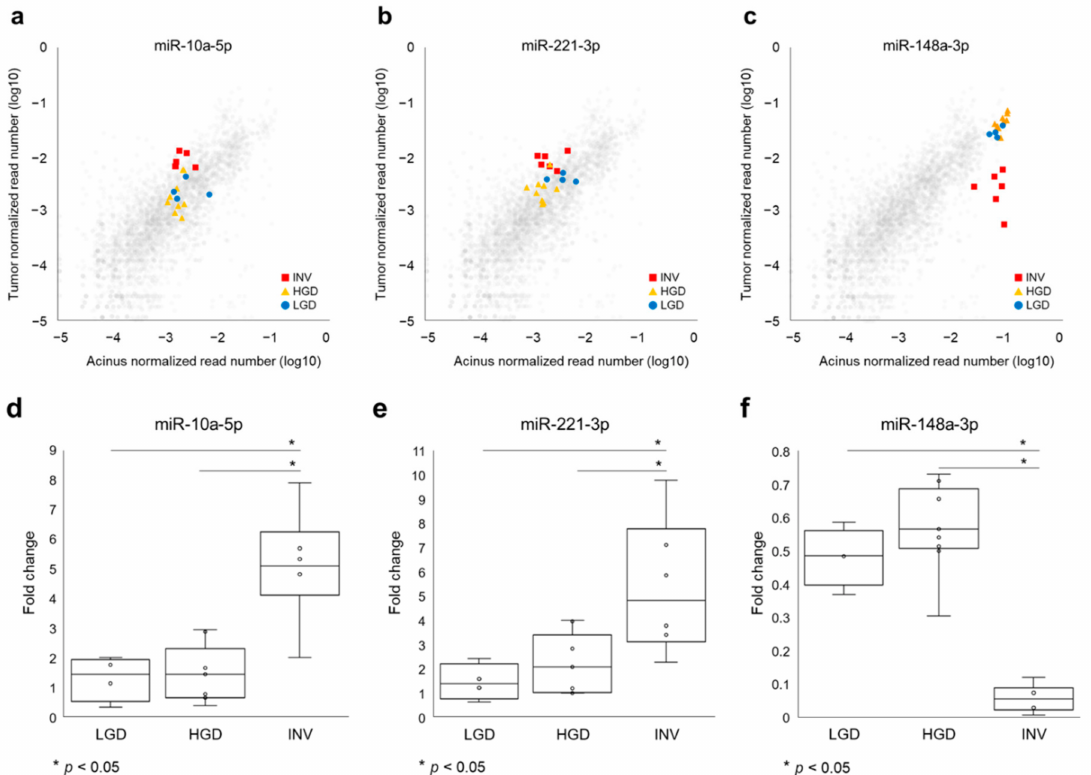
Figure 3. Candidate biomarker miRNAs in intraductal papillary mucinous neoplasm (IPMN) tissues to differentiate invasive IPMNs from noninvasive IPMNs. ( a , d ) MiR-10a-5p and ( b , e ) miR-221-3p were significantly upregulated in invasive carcinoma (INV) compared to low-grade dysplasia (LGD) and high-grade dysplasia (HGD). ( c , f ) MiR-148-3p was downregulated in INV compared to LGD and HGD. Gray dots indicate all other normalized read numbers of miRNA for each grade. Table 1. A post hoc analysis of 15 microRNAs that exhibited significantly different expression patterns among three histological grades (Kruskal–Wallis test, p < 0.05). LGD vs. HGD LGD vs. INV HGD vs. INV p Value p Value p